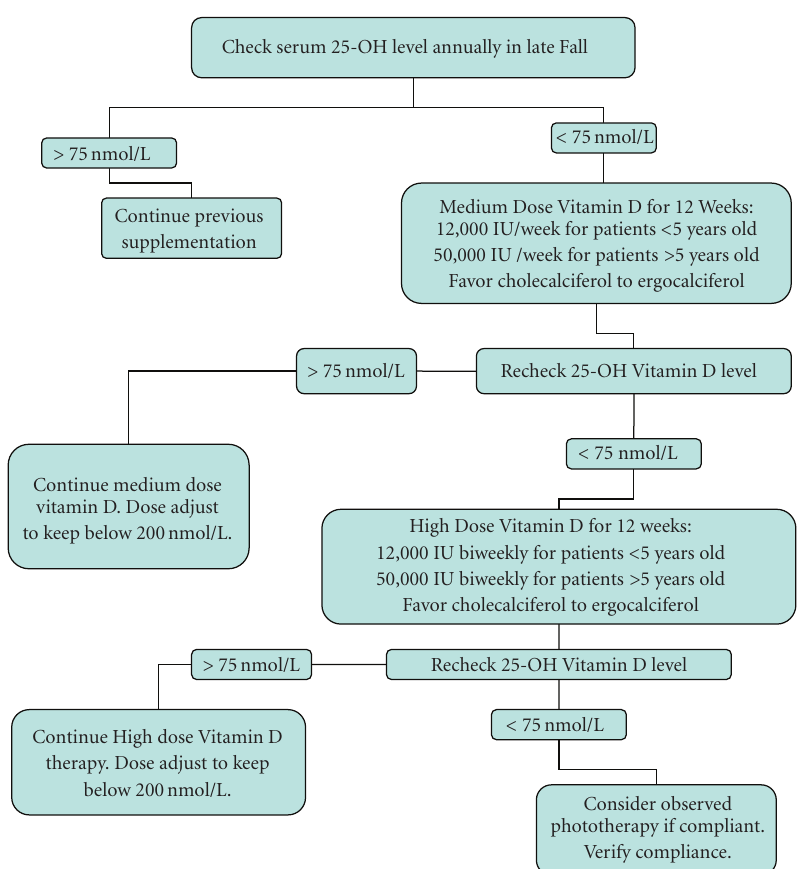
Figure 3: Suggested Vitamin D supplementation